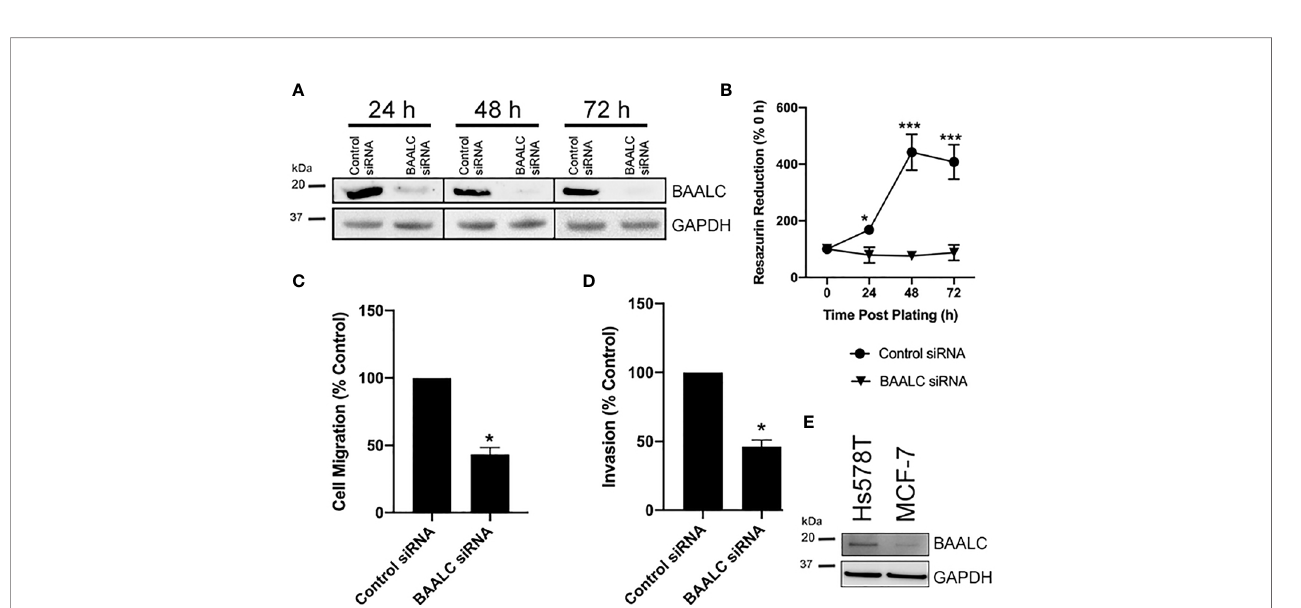
FIGURE 5 | Knocking down BAALC expression decreases Hs578T proliferation, migration and invasion in vitro . Hs578T cells were transfected with a pool of siRNA directed against BAALC, or a controlled scrambled sequence. (A) Top BAALC expression at various times post-transfection was examined by western blot, bottom GAPDH as a loading control. (B) Cells were plated immediately following transfection and cell viability was measured at 0, 24, 48, and 72 h post-plating via Cell Titre Blue Assay. n=3 in triplicate. (C) Forty-eight hours post-transfection, cells were placed in the upper chamber of a Transwell and allowed to migrate through the uncoated membrane (8 µm pore) for 4 h. n=3 performed in triplicate. (D) Forty-eight hours post-transfections, cells were examined for ability to invade through Matrigel plugs. (E) Endogenous levels of BAALC protein in Hs578T and MCF7 cells. n=3 performed in triplicate. * denotes statistical signi fi cance p < 0.05. *** denotes statistical signi fi cance p <